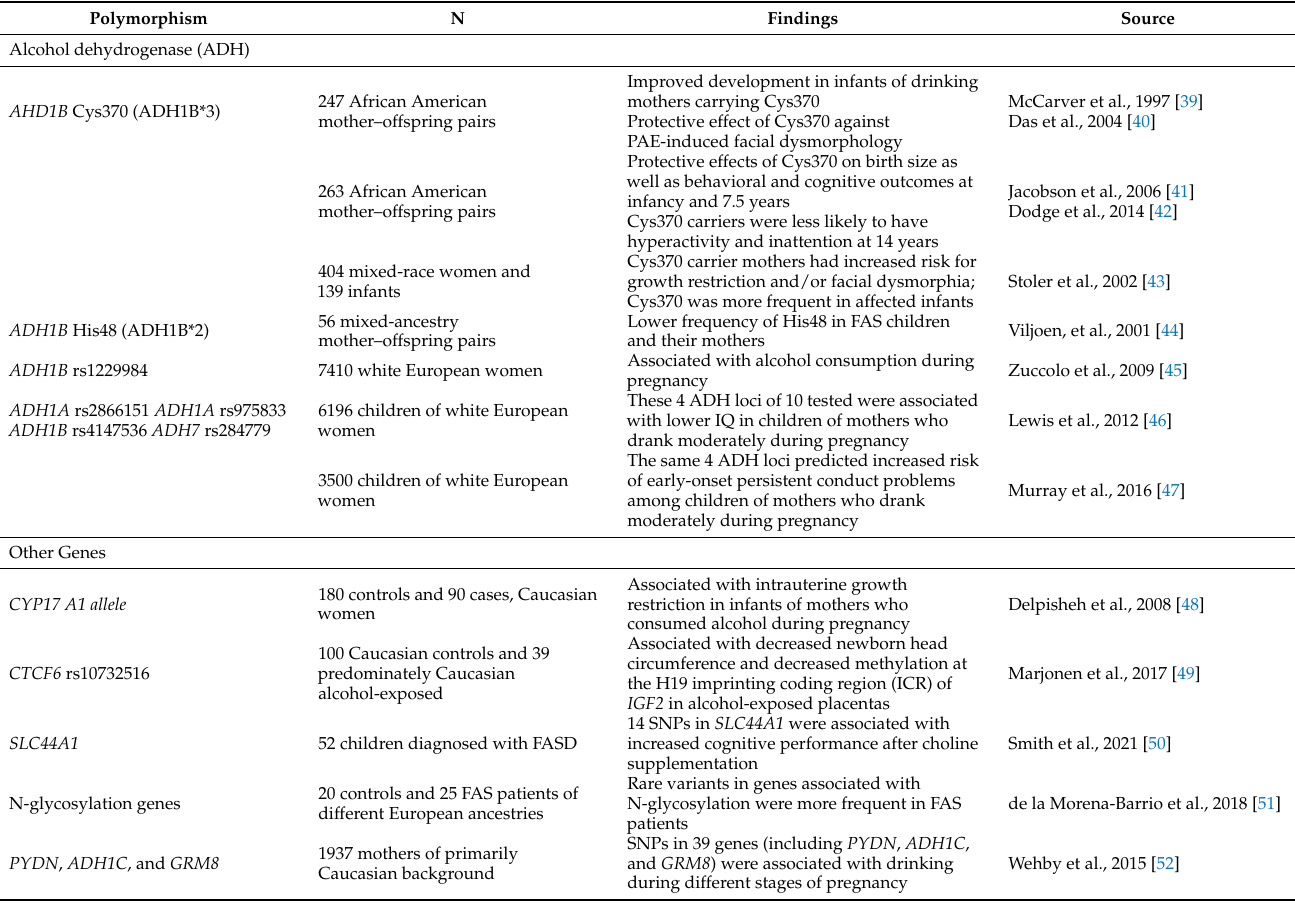
Table 1. Polymorphisms associated with PAE and